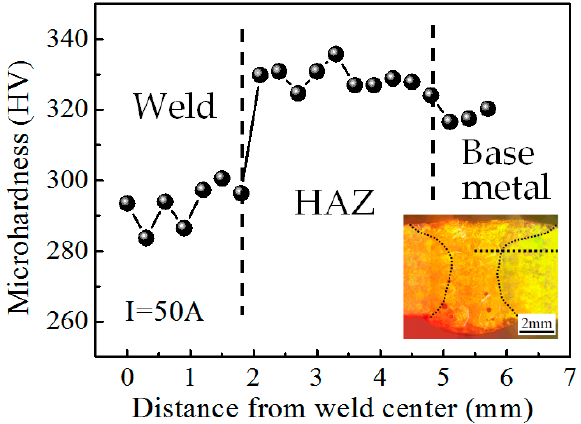
Figure 16. Microhardness distribution of welded joint.